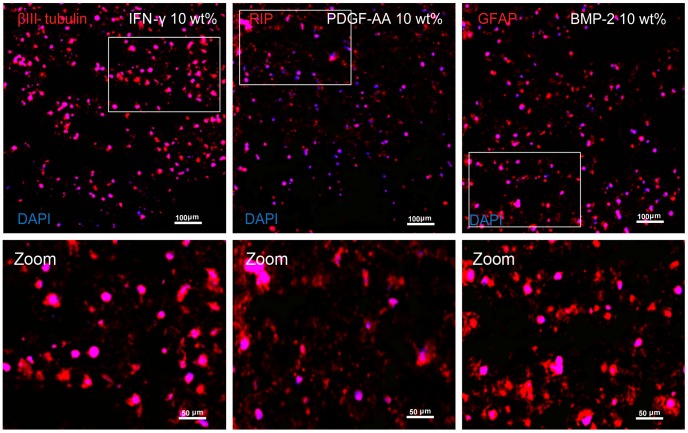
Multiphoton confocal images of fluorescence staining for neurons, oligodendrocytes and astrocytes in 10 wt% scaffolds obtained at the center region of whole scaffolds.Corresponding zoomed regions (white rectangle) for each image are provided below. Nuclei appear blue by Hoechst 33342, cell staining for each differentiation marker appear red by Alexa-Fluor 546.